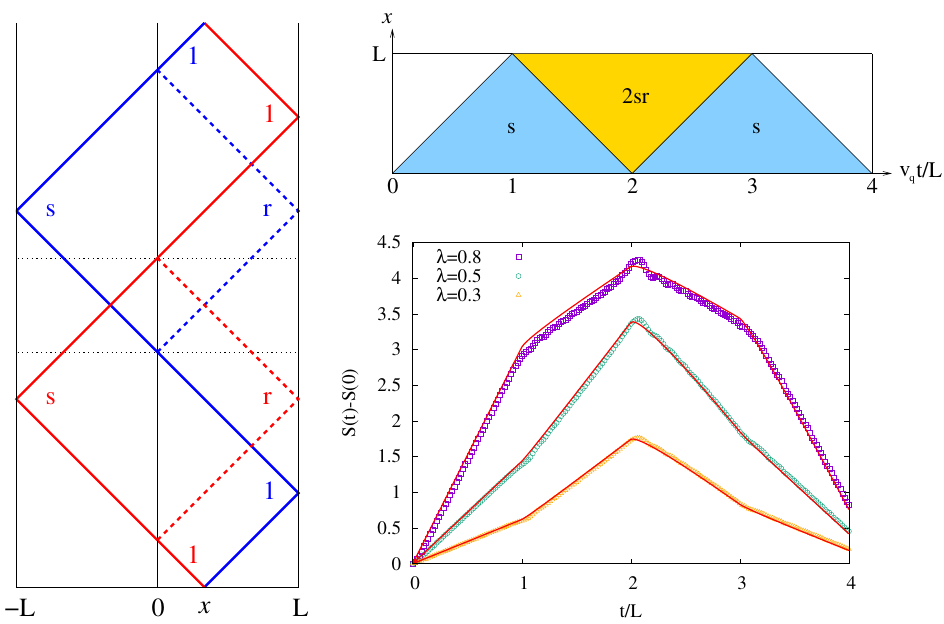
Figure 10: Left: quasiparticle trajectories with corresponding amplitudes. Top right: initial locations of quasiparticle pairs that contribute in the first full period t < 4 L . The shaded regions show the contributions with the amplitudes indi- 0 < v q cated. Bottom right: entropy growth compared to the quasiparticle ansatz